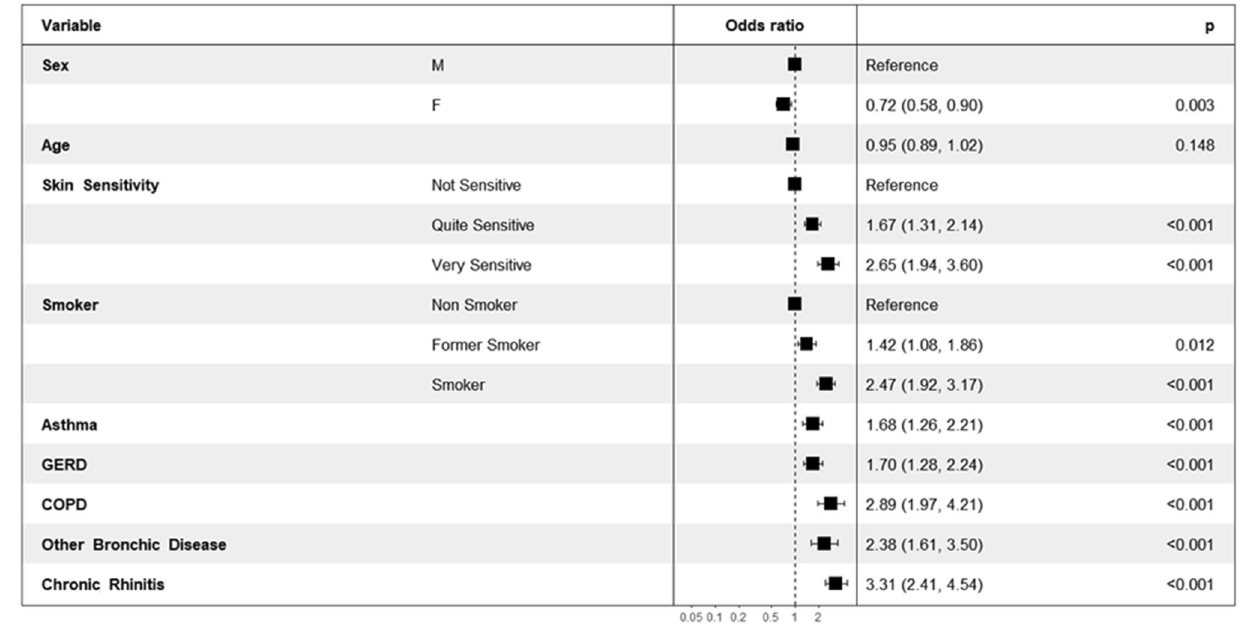
Figure 1. Multivariate analysis in patients with chronic cough.